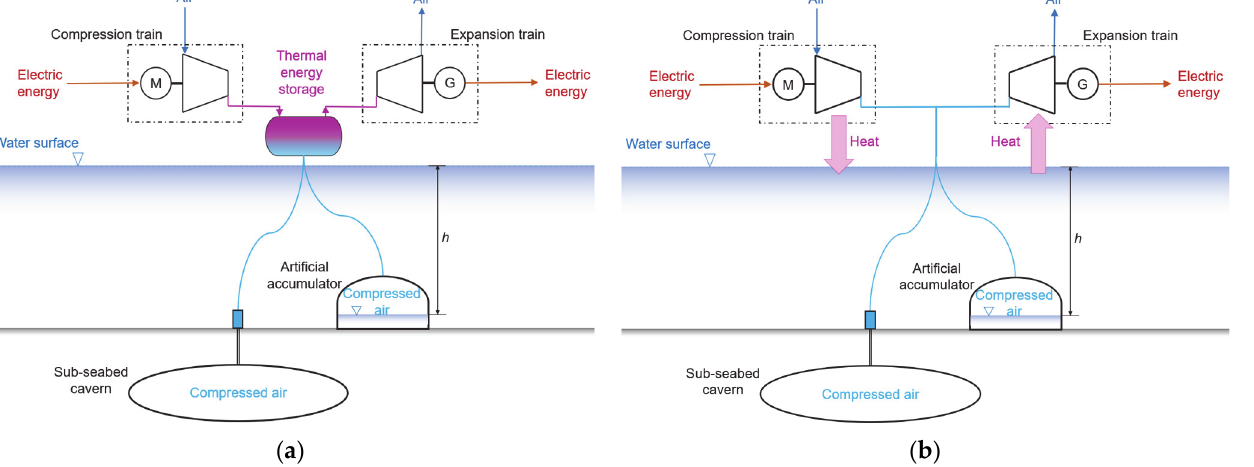
Figure 2. Timeline of major academic and industrial milestones of UWCAES. The point ‐ in ‐ time is confirmed according to the earliest traceable publications or announcements. The data go through June 2020. For the upper academic area, the length of the dotted line is related to the number of publications of various institutes of corresponding authors. For the lower industrial area, the length of the dotted line means the development status of various enterprises. Red points show the most important milestones of UWCAES. Several important underwater hydrogen energy storage cases are also included, such as TechnipFMC, Tractebel, and SBT. (BEST: Bright Energy Storage Tech ‐ nologies; BU: Baylor University; CAS: Chinese Academy of Science; DMU: Dalian Maritime Uni ‐ versity; FNA: French Naval Academy; IAU: Islamic Azad University; IIASA: International Institute for Applied Systems Analysis; IMTA: IMT Atlantique; NCSU: North Carolina State University;